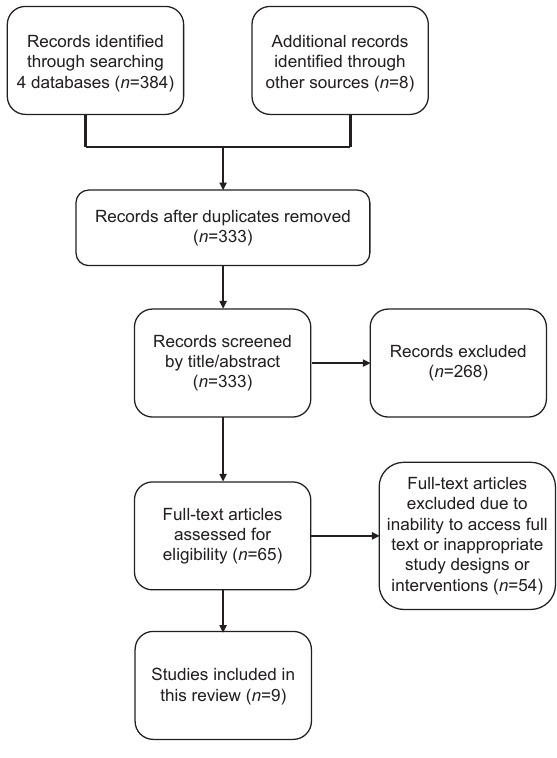
Figure 1. Article search